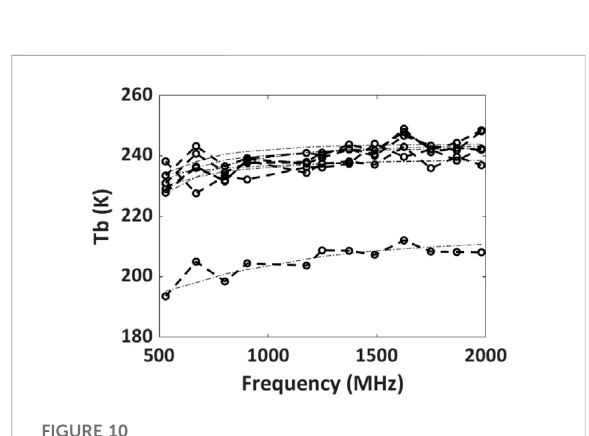
FIGURE 10 Sea ice spectra acquired over the Lincoln Sea in September 2017. Brightness temperatures warmer than 220 K are from multiyear sea ice fl oes. Colder temperatures are from thin